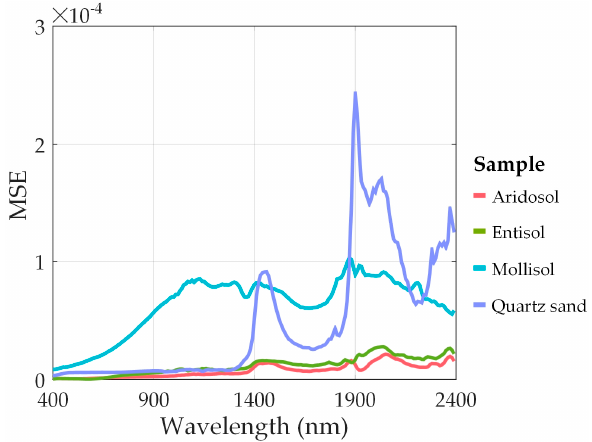
Figure 9. The MSE ( ε , r s , t 1 , t 2 , θ s ) values of four soil Figure 9. The MSE((cid:2013), (cid:1870) (cid:3046) , (cid:1872) (cid:2869) , (cid:1872) (cid:2870) ,(cid:2016) (cid:3046) ) values of four soil samples.